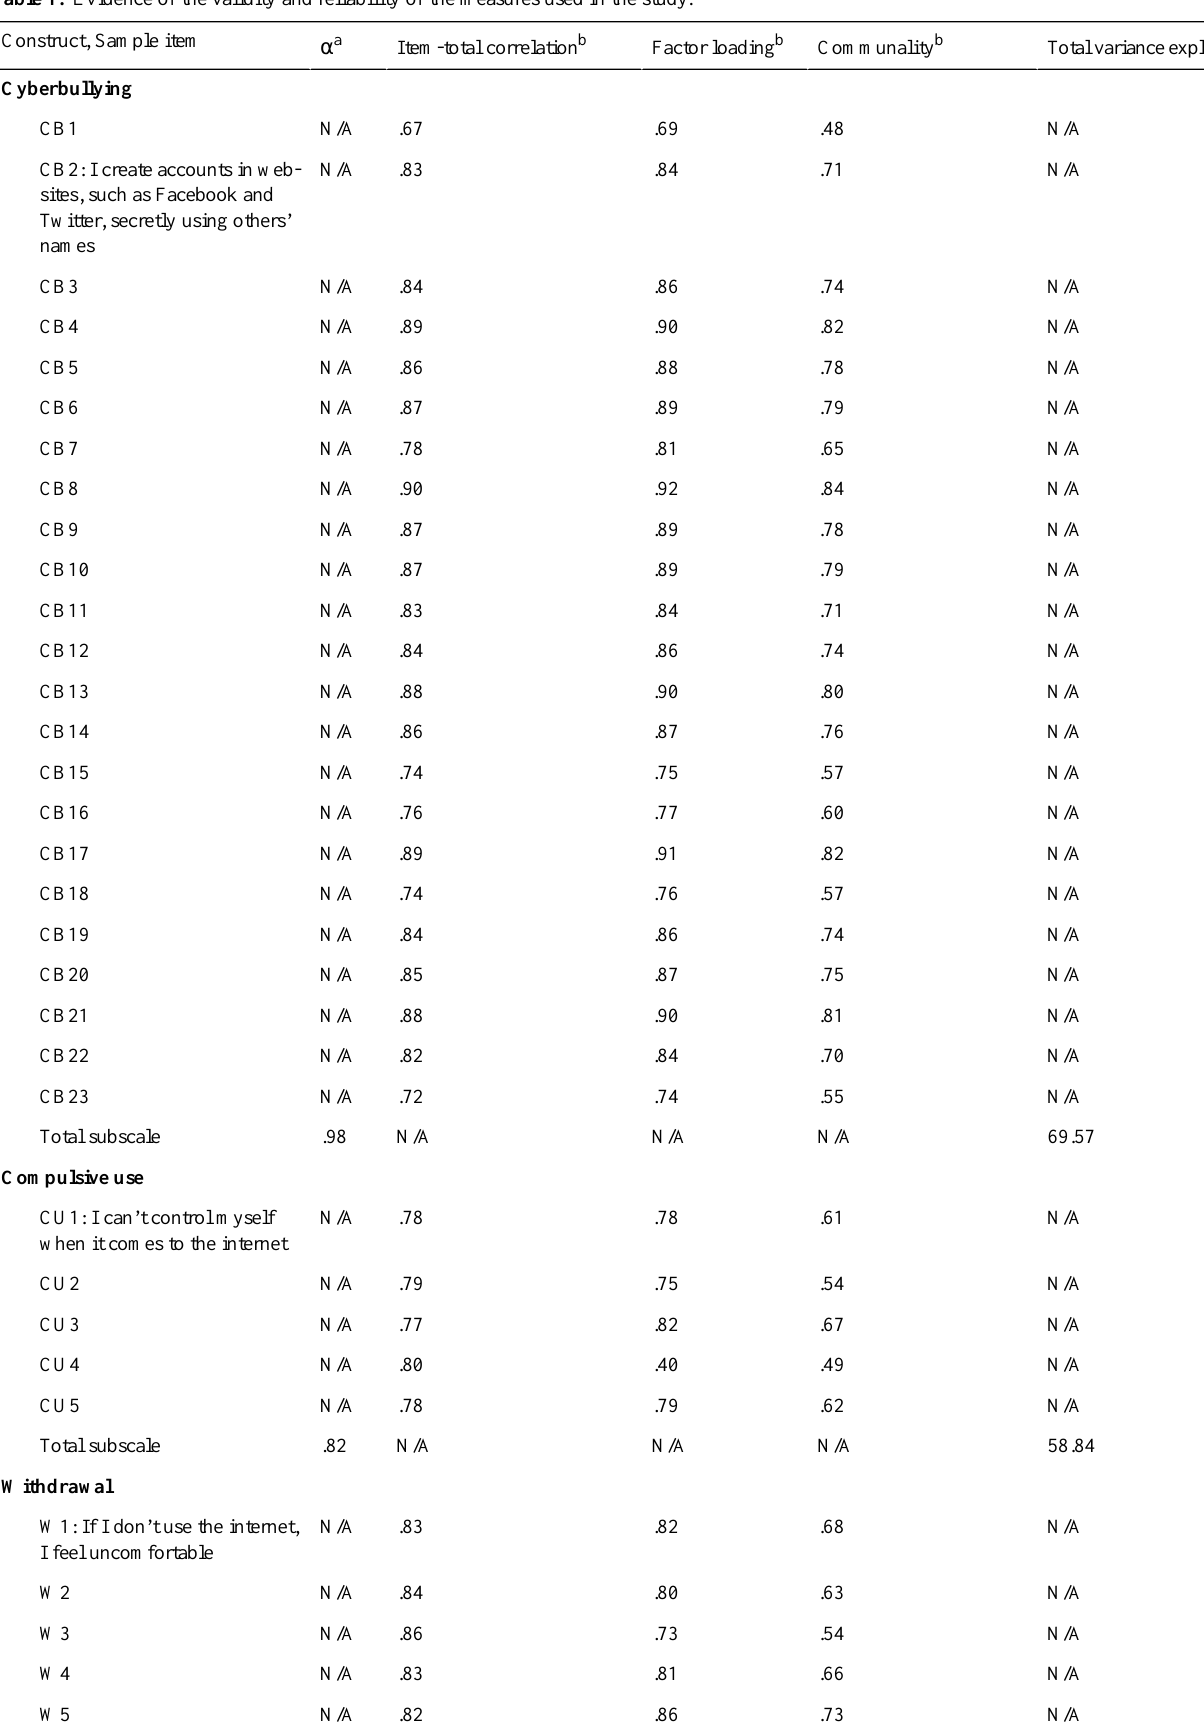
Table 1. Evidence of the validity and reliability of the measures used in the